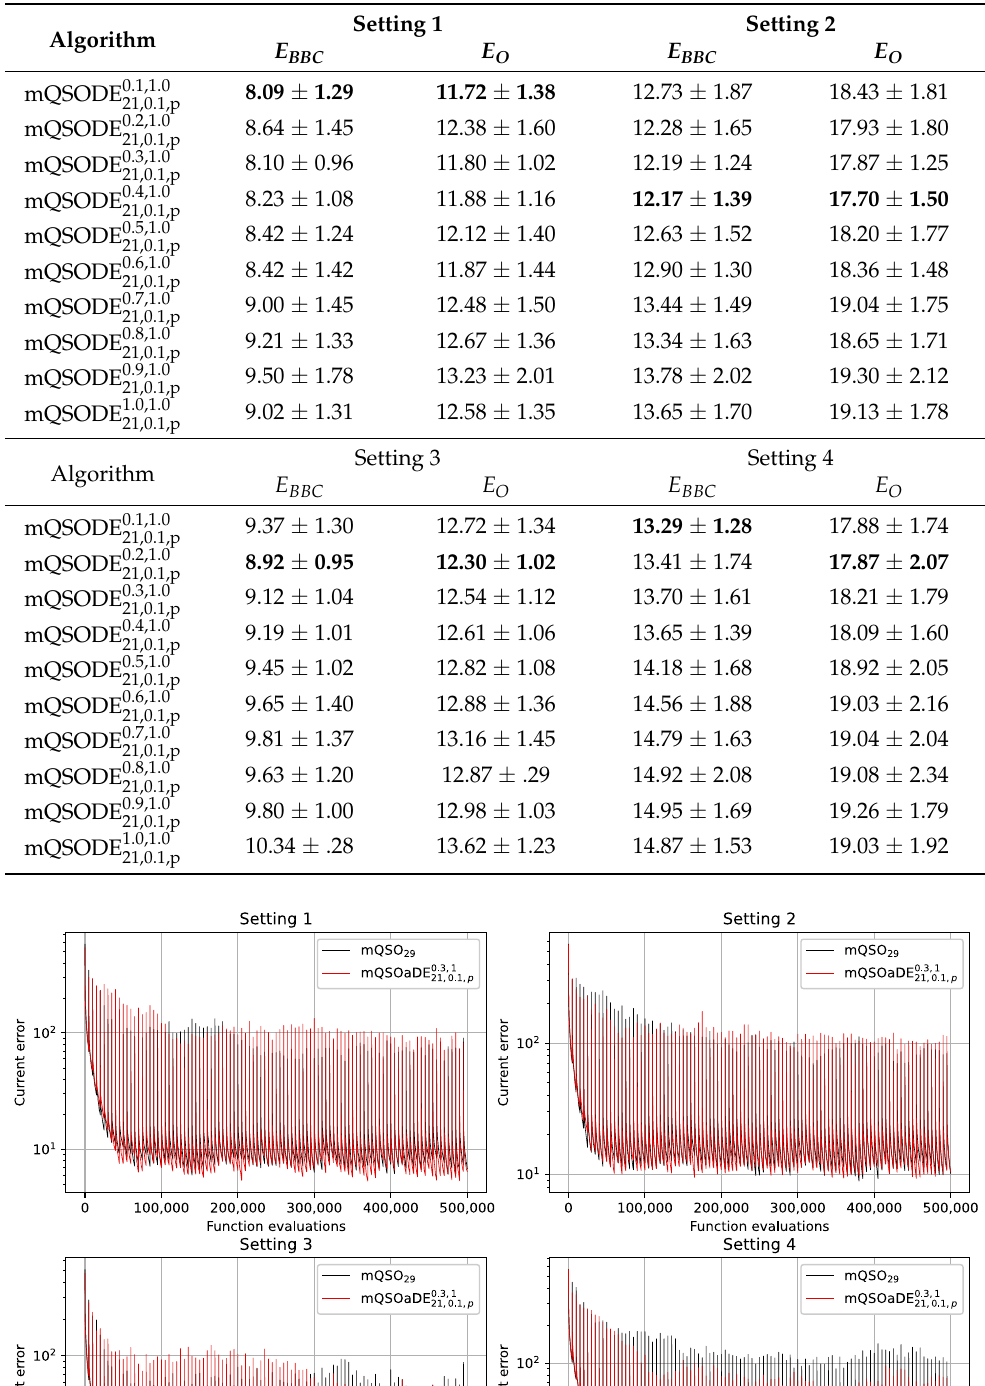
Table 9. Pairwise Mann-Whitney tests of mQSO and mQSODE, all settings, test results, and standard scores.